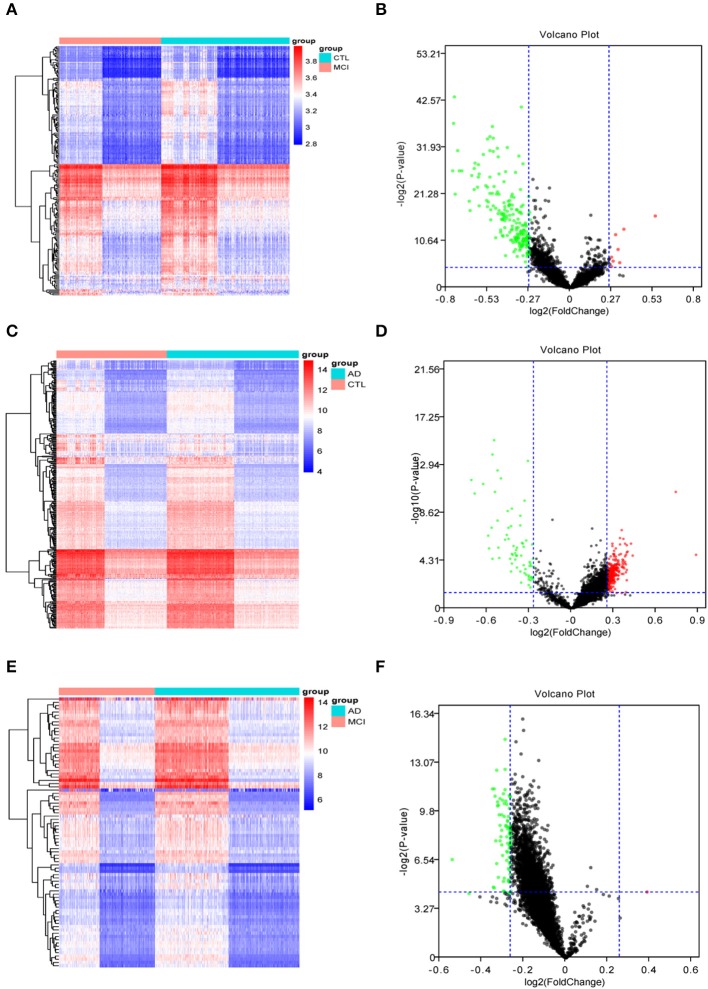
The heat maps and volcano plots of differentially expressed genes (DEGs) were obtained by cluster analysis. The horizontal axis represents the specimen in heat maps: CTL represents the normal sample, MCI represents the mild cognitive impairment sample, and AD represents the Alzheimer's disease sample. Red indicates genes that are up-regulated, while blue indicates genes that are down-regulated in heat maps. Red indicates genes that are up-regulated, while green indicates genes that are down-regulated in volcano plots. (A,B) The heat map and volcano plot of differentially expressed genes between MCI samples and normal samples. (C,D) The heat map and volcano plot of differentially expressed genes between AD samples and normal samples. (E,F) The heat map and volcano plot of differentially expressed genes between MCI and AD samples.